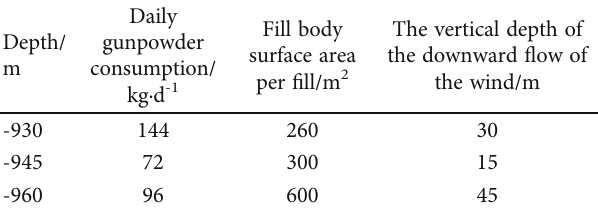
Table 5: Other relevant